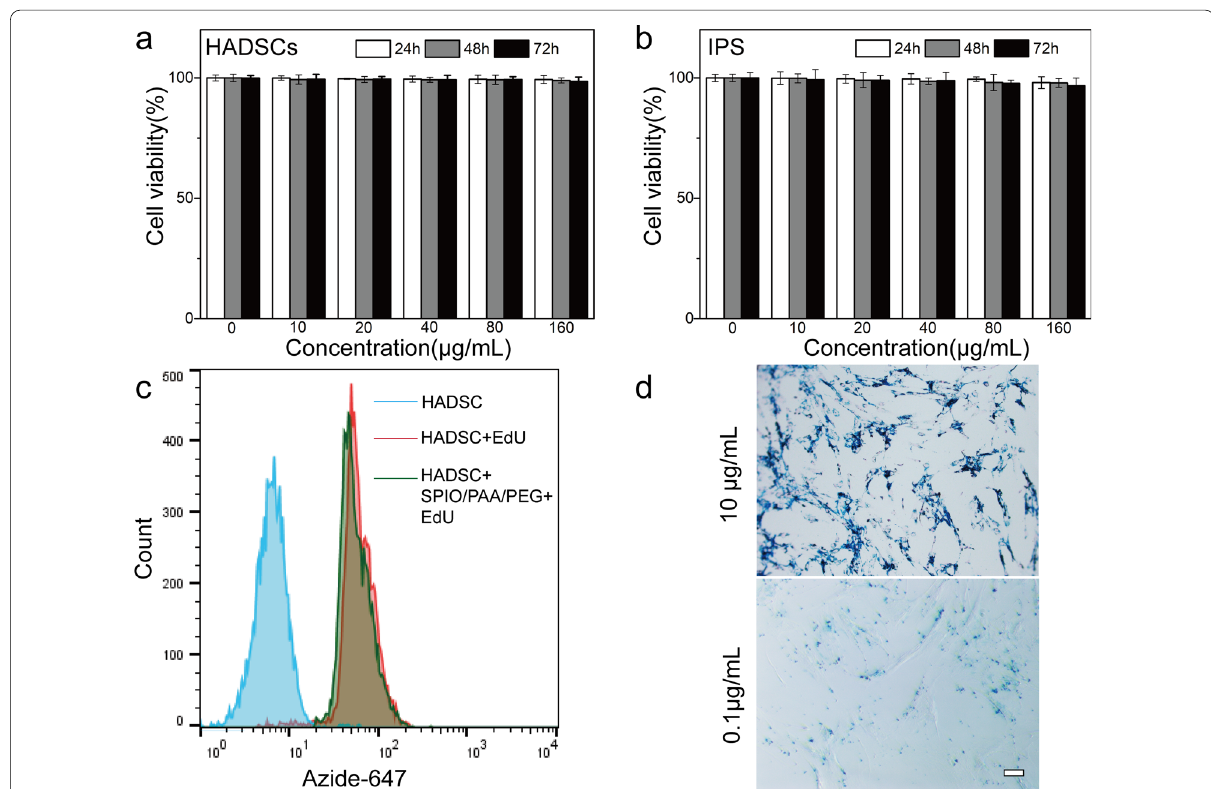
Fig. 4 The synthesized USPIO-PAA/PEG NPs show good biocompatibility and labeling capability. a , b HADSCs or iPSCs were incubated with USPIO-PAA/PEG NPs at varying concentrations (equivalent to Fe concentrations at 0, 10, 20, 40, 80 and 160 μg Fe/mL) for 24, 48, and 72 h, and the cell viability was determined by MTT method and shown in a , b , respectively. There is no significant difference among the viabilities at different NPs concentration ( n 5) or incubation time ( n 5). c Flow cytometry analysis showed that the EdU incorporation rates were similar in = = the HADSCs incubated in the presence or absence of USPIO-PAA/PEG (160 μg Fe/mL for 72 h). HADSCs did not treated with EdU were served as negative control. d USPIO-PAA/PEG at 10 μg Fe/mL and incubation time for 2 h resulted in almost 100% labeling efficiency of HADSCs, as evaluated by Prussian blue staining. Note that USPIO-PAA/PEG at 0.1 μg Fe/mL (2 h incubation time) produced light but uniform PB stain in the HADSCs. Numerical data are presented as mean SD. The bar represents 20 ±